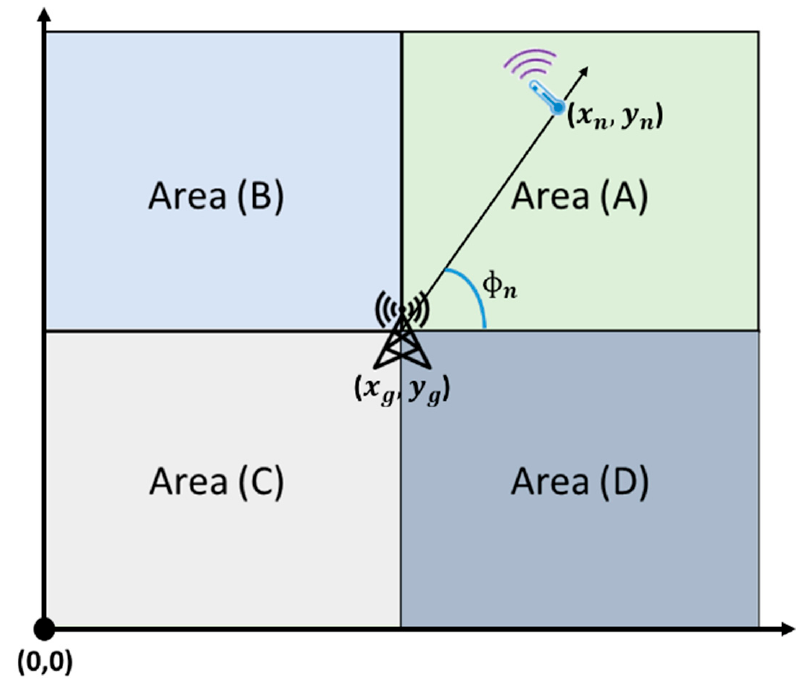
Figure 4. SCAP SigFox area categorization.